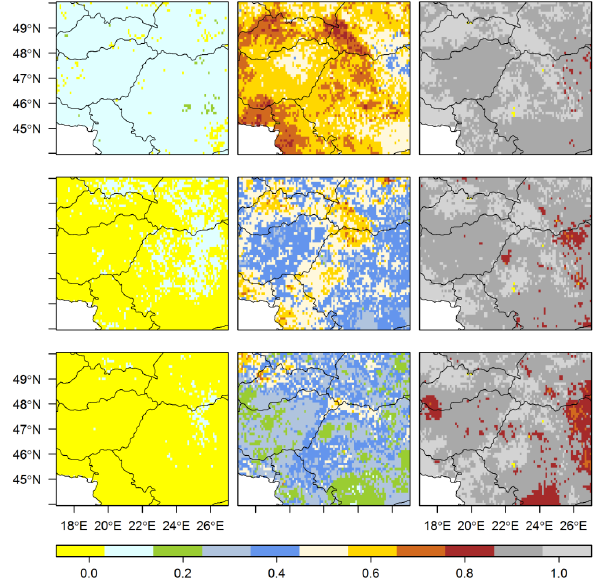
Figure 6. Percentage (%) above the normal precipitation needed to end a (top) moderate ( − 3<Sc-PDSI ≤ − 2), (center) severe ( − 4<Sc-PDSI ≤ − 3) and (bottom) extreme drought (SC-PDSI ≤ − 4) in the next month (left), next 3 months (center) and next 6 months (right) (1961–2010).